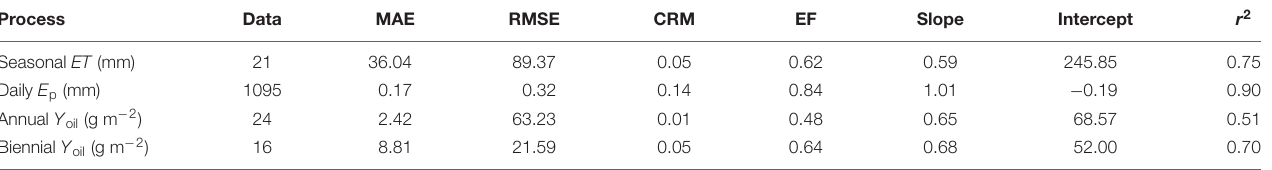
TABLE 2 | Performances of OliveCan in reproducing the experimental data gathered for the model testing. Process Data MAE RMSE CRM